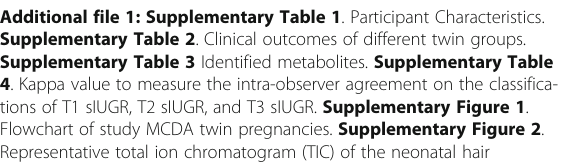
Additional file 1: Supplementary Table 1 . Participant Characteristics. Supplementary Table 2 . Clinical outcomes of different twin groups. Supplementary Table 3 Identified metabolites. Supplementary Table 4 . Kappa value to measure the intra-observer agreement on the classifica- tions of T1 sIUGR, T2 sIUGR, and T3 sIUGR. Supplementary Figure 1 . Flowchart of study MCDA twin pregnancies. Supplementary Figure 2 . Representative total ion chromatogram (TIC) of the neonatal hair